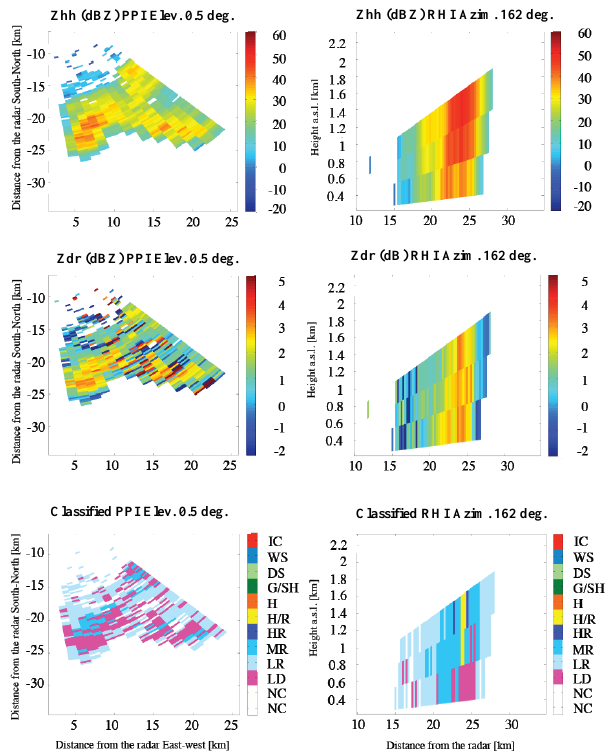
6 Figure 5. Example of a rain cell as seen from Horesti radar installation on Sep. 9, 2011 at Fig. 5. Example of a rain cell as seen from Horesti radar installation 12:55 UTC in terms of Z hh , Z dr and the classified products for PPI horizontal maps at 0.5° (left on 9 September 2011 at 12:55 UTC in terms of Z hh , Z dr and the column) and RHI vertical sections (right panel) classified products for PPI horizontal maps at 0.5 ◦ (left column) 7 and RHI vertical sections (right panel). 8